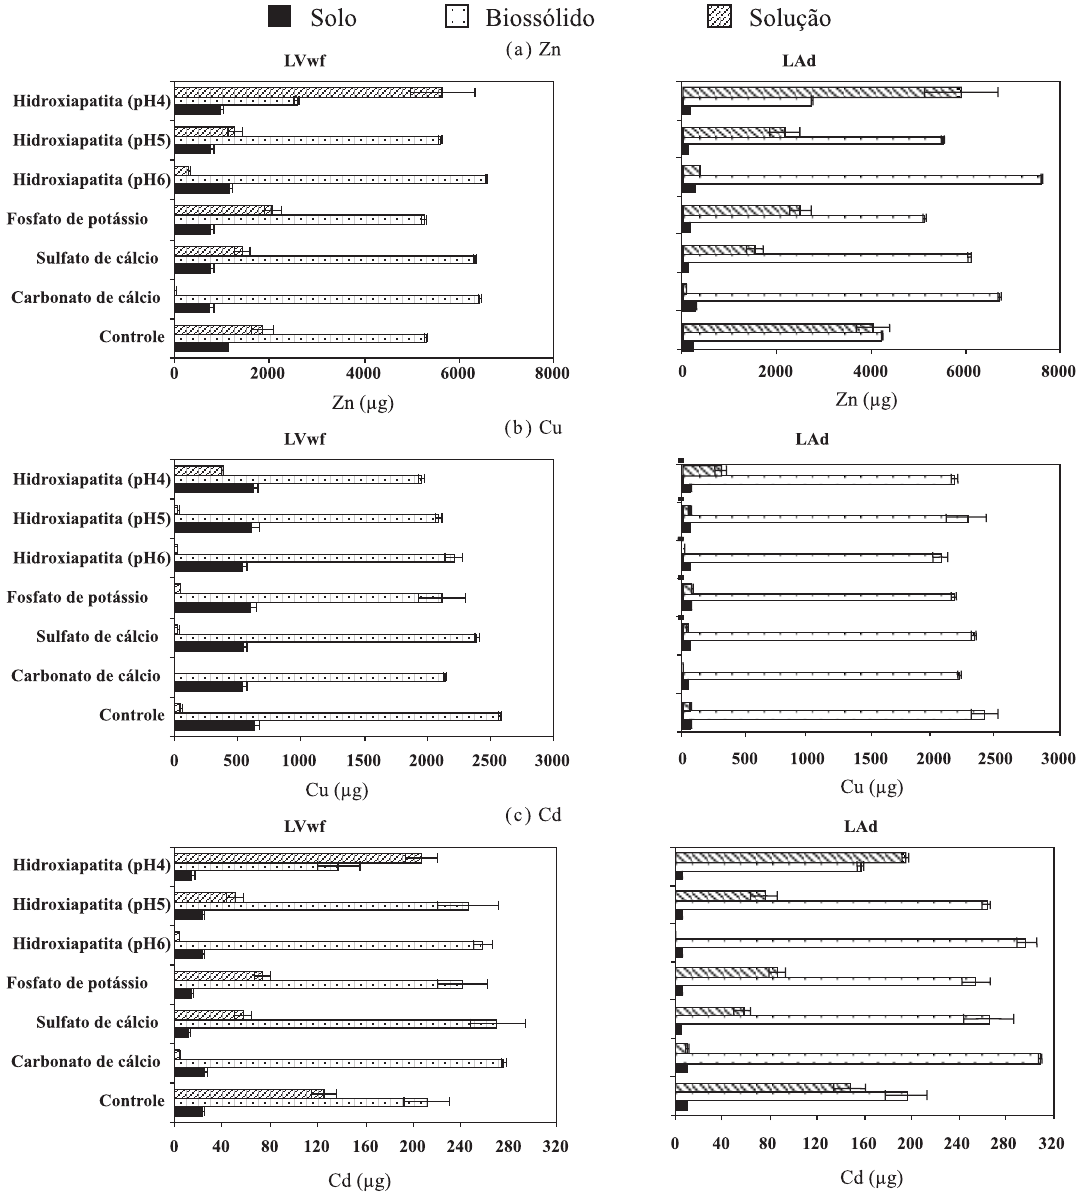
Figura 2. Distribuição de zinco, cobre e cádmio na fase sólida (2 g de terra e de biossólido) e em solução (500 mL) após o equilíbrio nas câmaras duplas de difusão. Controle: amostras sem adição de condicionadores; LVwf: Latossolo Vermelho acriférrico; LAd: Latossolo Amarelo distrófico. Barras representam